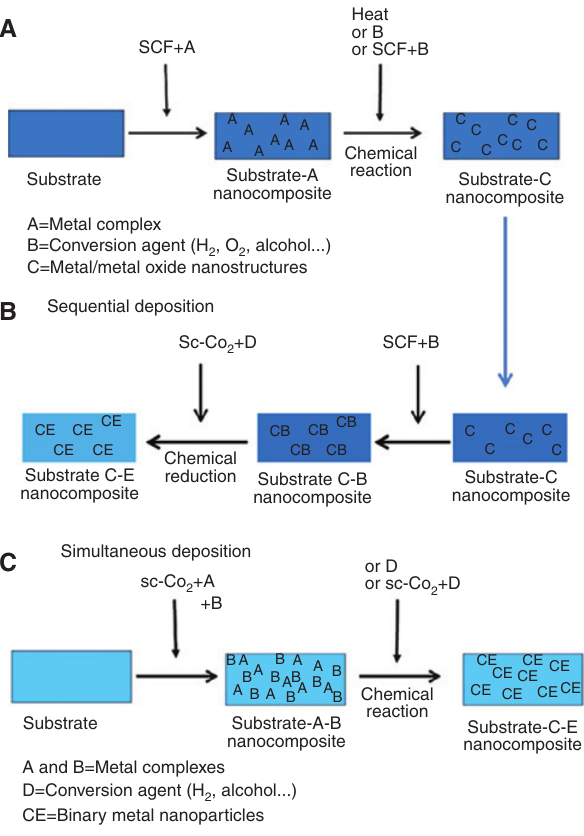
Figure 5: Thermodynamic control of SFCD for preparing NP-based structured materials: (A) metal or metal oxide NPs; (B, C) binary